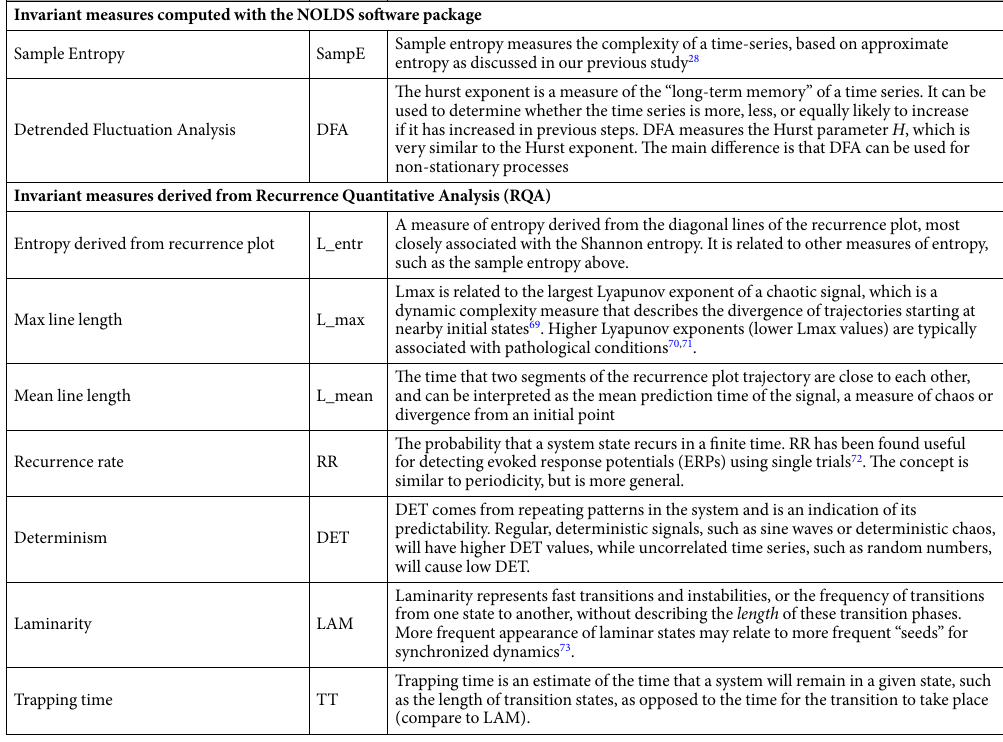
Table 3. Nonlinear invariant measures of a time series and their physical